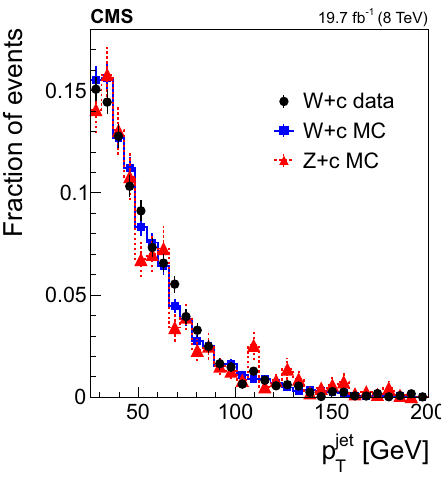
W + c distributions are presented after the OS − SS subtraction. Vertical bars represent the statistical uncertainties